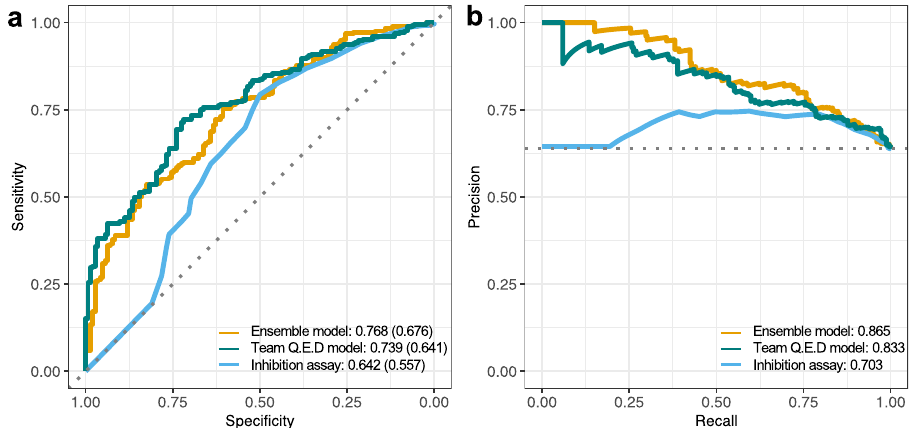
Fig. 7 Top-performing model predictions compared against single-dose assays. a Receiver operating characteristic (ROC) curves when ranking the 394 compound-kinase pairs in Round 2 using the pK d predictions either from the ensemble of the top-performing models (average predicted pK d from Q.E.D, DMIS_DK and AI Winter is Coming), or only from the Q.E.D model, compared against the experimental single-dose inhibition assays (the pairs with higher inhibition% are ranked fi rst). The true positive activity class contains pairs with measured pK d > 6 (see Supplementary Fig. 15 for pK d > 7). The area under the ROC curve values are shown after the predictors (and the balanced accuracy is marked in the parentheses), and the diagonal dotted line shows the random predictor with an accuracy of AU-ROC = 0.50. b Precision-recall (PR) curves for the same activity classi fi cation analysis as shown in a . The area under the PR curve values are shown after the predictors and the horizontal dotted line indicates the random predictor with a precision of 0.64. Note: Round 2 K d measurements were pre-selected to include mostly pairs with single-dose inhibition >80%, which makes Round 2 pairs optimal for systematic analysis of false positive predictions, and hence sensitivity (recall) and PPV (precision). However, these 394 pairs pre-selected for K d pro fi ling were less optimal for a comprehensive analysis of false negative predictions, and the evaluation of speci fi city. Source data are provided as a Source Data fi le 54